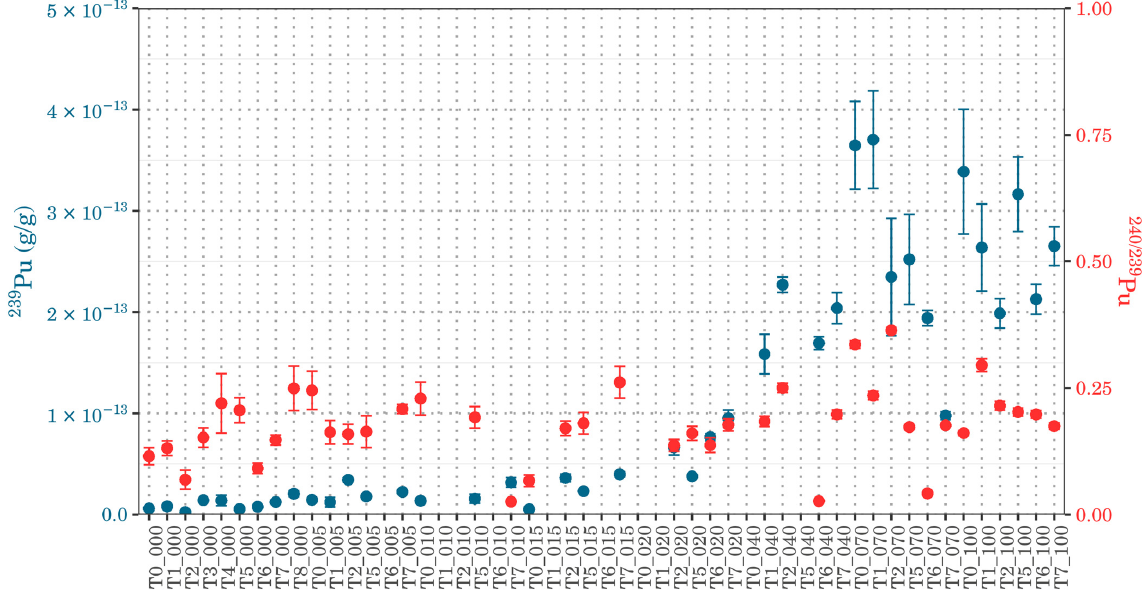
Figure 11. Concentration of 239 Pu (in blue, on the left) and 239/240 Pu isotopic ratio (in red, on the right) in marine sediments. The samples in abscissa are arranged by increasing depth of sampling. Values below the detection limit are not shown.